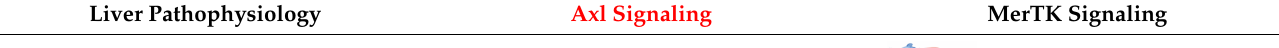
Table 2. Summary of major findings of TAM receptors in pathophysiology of liver